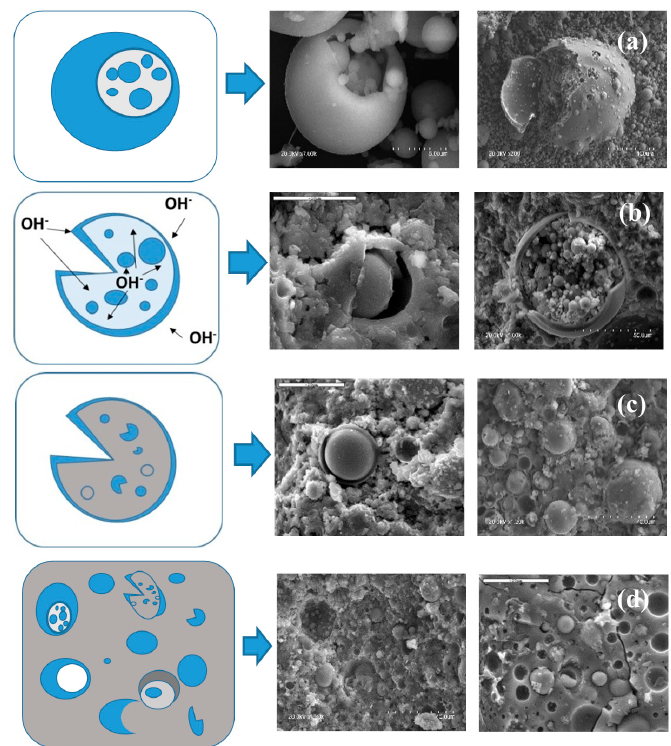
Figure 3. Conceptual model for AAFA cement hydration. ( a ) Starting material; ( b ) initial alkaline attack on the ashes and early N–A–S–H gel formation; ( c ) gel polymerisation and positioning on the inner and outer surfaces of the exposed fly ash; and ( d ) mature and heterogeneous AAFA cement paste microstructure (adapted from Fernández and Palomo [7]).